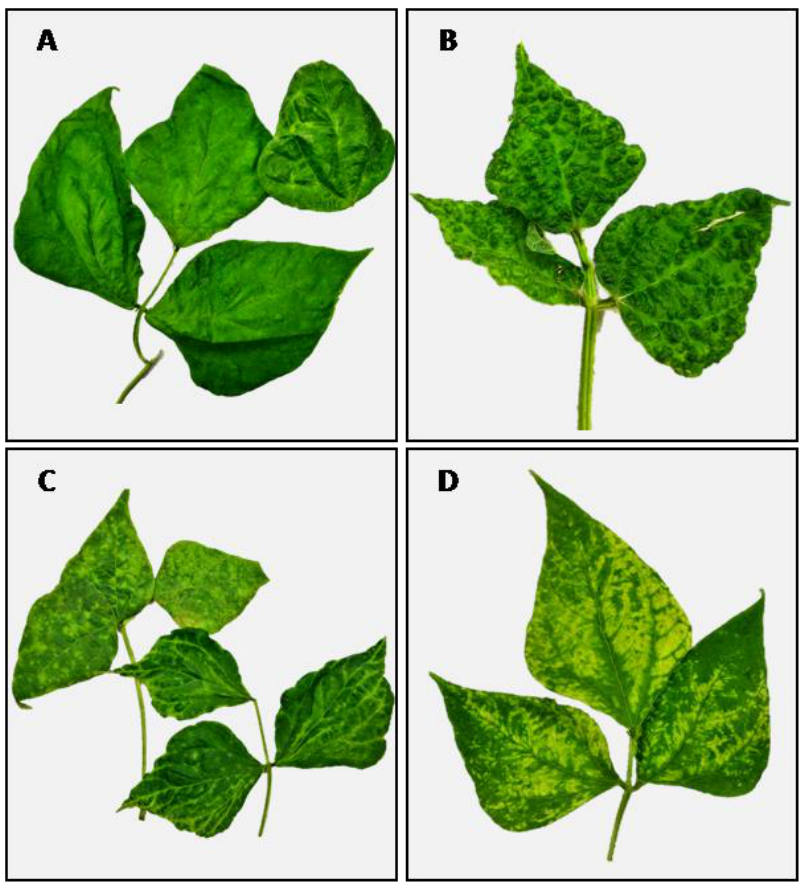
Figure 1. Description of virus-like symptoms observed in Lamon beans. Mild ( A ) and severe ( B ) leaf mottling and deformation on Lamon bean ecotype Canalino and Calonega, respectively. Mild ( C ) and severe ( D ) yellow chlorosis on Lamon bean ecotype Spagnolet.